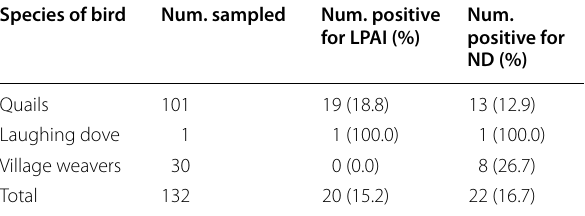
Table 1 Positivity and percentage of LPAI and ND virus antibodies in quails, laughing dove and village weavers in the study area Species of bird Num. sampled